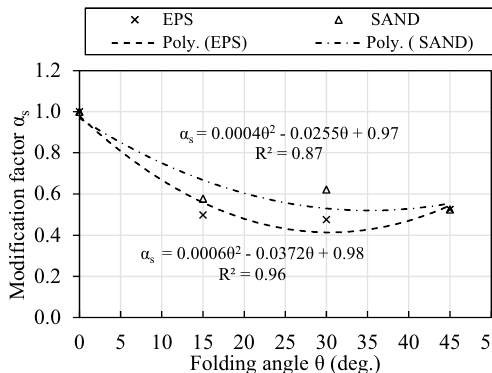
Fig. 19 Settlement modification factor for various folding angles